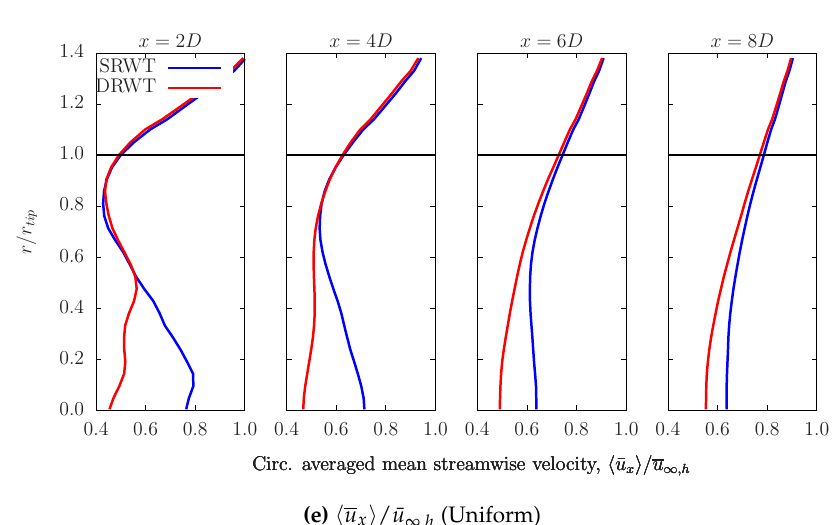
Figure 8. Comparison between SRWT and DRWT of normalized mean streamwise velocity, u x / u ∞ , h : ( a , b ) on the x - z plane passing through the rotor hub; ( c , d ) on cross-stream ( y - z ) planes; and ( e ) circumferentially averaged values at four downstream locations ( x / D = 2, 4, 6, and 8) for the uniform inflow